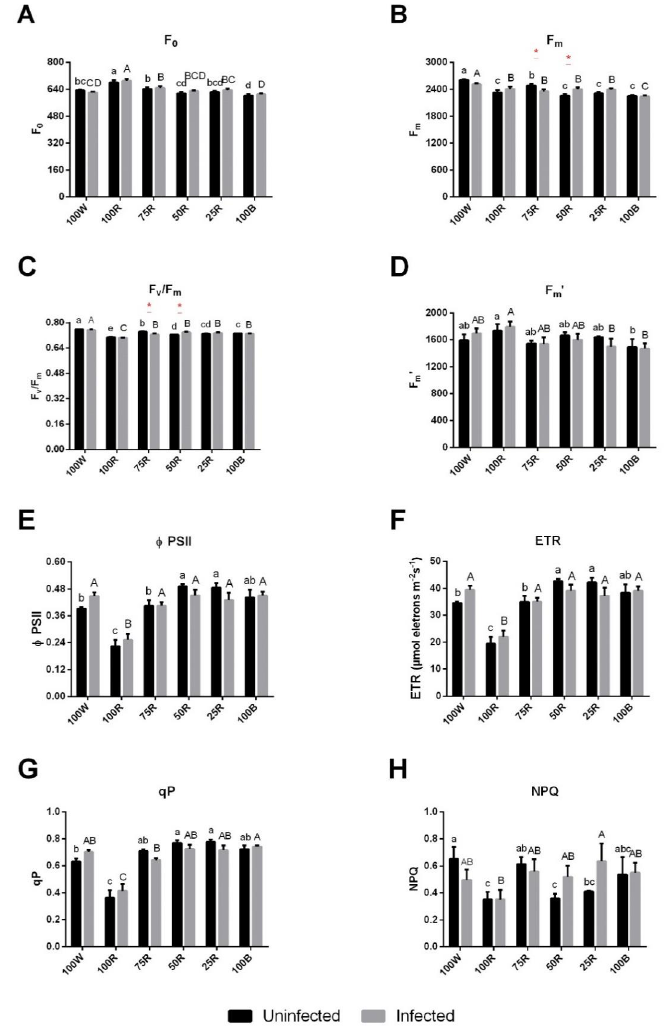
Figure 2. Effect of light quality on Chlorophyll a fluorescence. Minimal fluorescence yield of dark- adapted leaves, F 0 ( A ); maximum fluorescence of dark-adapted leaves, F m ( B ); maximum quantum efficiency of PSII, F v /F m ( C ); maximum fluorescence of light-adapted leaves, F m ’ ( D ); effective effi- ciency of PSII, ΦPSII ( E ); Electron transport rate, ETR ( F ); photochemical quenching, qP ( G ) and non-photochemical quenching, NPQ ( H ). The values are presented as the mean of at least 3 biolog- ical replicates ± SE. Lowercase letters represent multiple comparisons of uninfected groups, capital letters are multiple comparisons of infected groups and asterisks are comparisons of uninfected and infected groups in the same light treatment. Mean values with the same letter or without asterisk are not significantly different (Fisher LSD, p < 0.05).